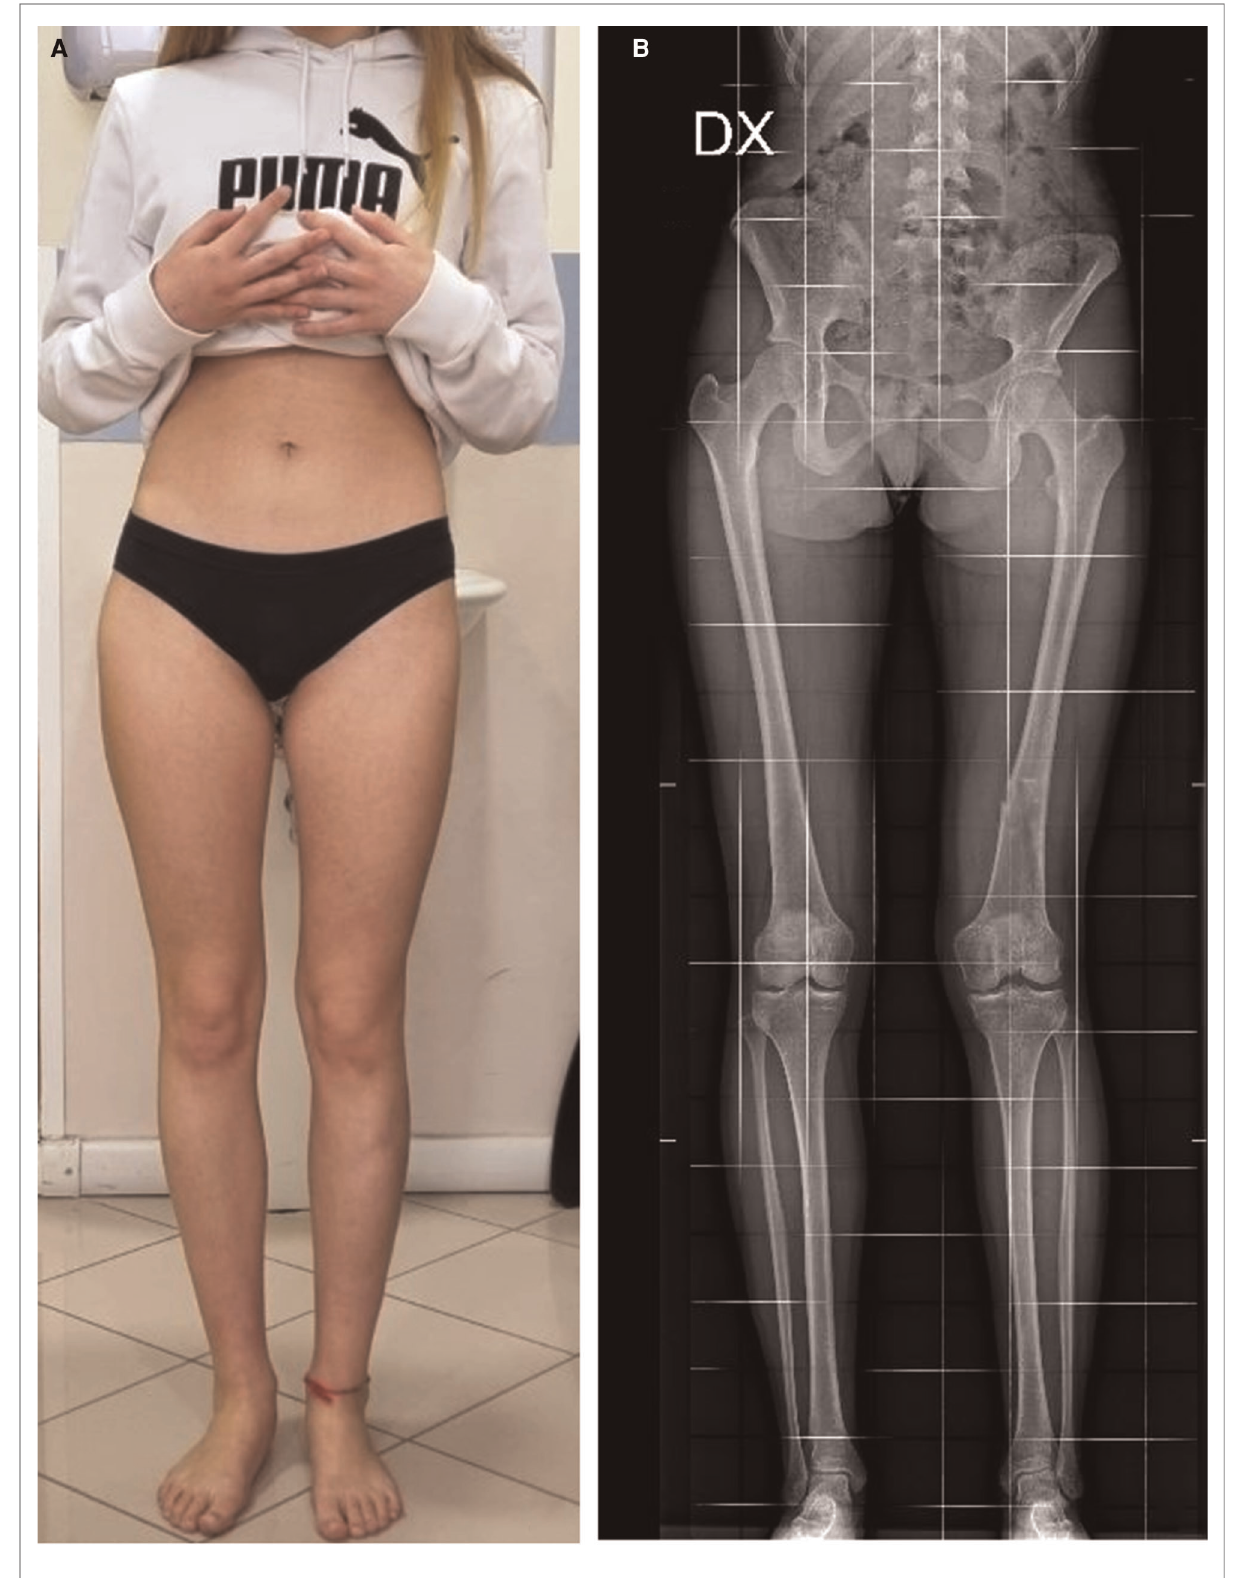
FIGURE 7 Ten-year post-trauma follow-up showing complete clinical ( A ) and radiological ( B )